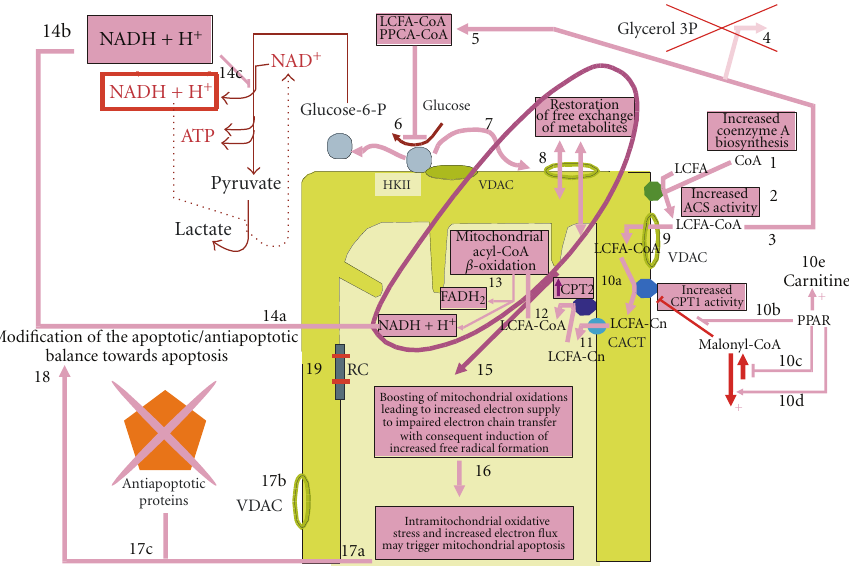
Figure 7: Potential anticancer value of metabolic changes interfering with Warburg’s e ff ect and mediated essentially by PPAR α (the metabolic events numbered in the figure are explained in the